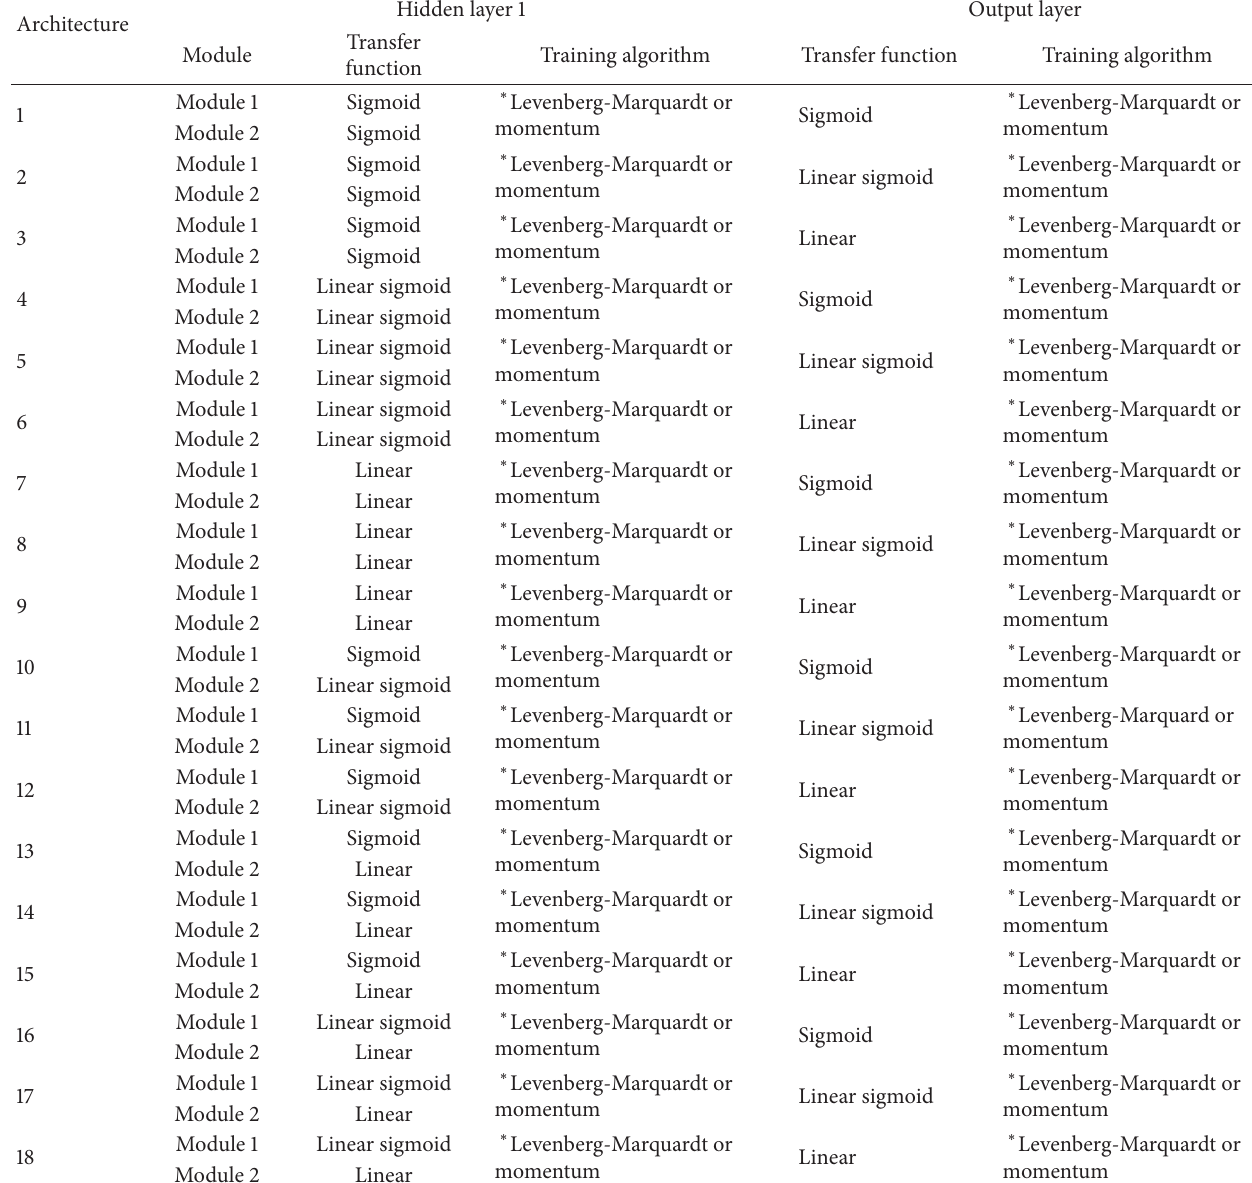
Table 3: Developed configurations of MNNs for Roodan